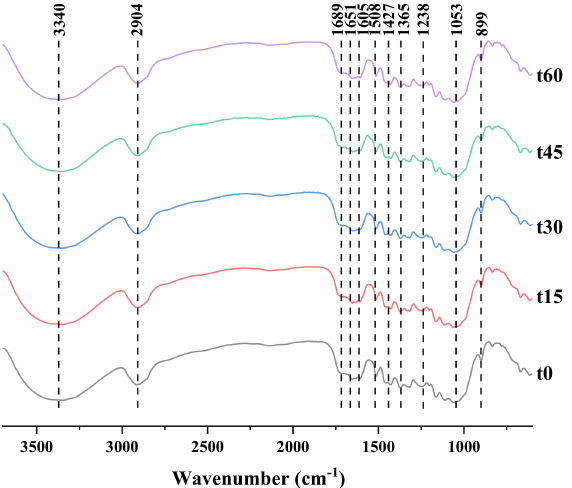
Figure 4. Infrared spectra of corn stalk treated with different ultrasound times.